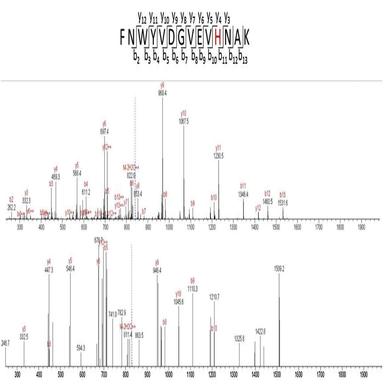
Tandem mass spectra of unmodified Lys-C peptide at m/z 839.90 (top) with His to Asp modification at m/z 828.29 (bottom). The modification site highlighted in red shows the localization of His (−22 Da mass shift) to the Asp residue, which is confirmed by the b and y fragment ions. (For interpretation of the references to colour in this figure legend, the reader is referred to the web version of this article).